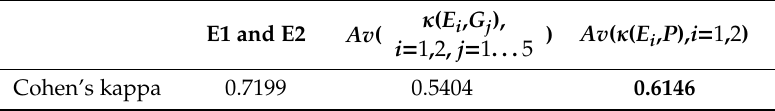
Figure 15. ( a ) good-quality images ( b ) inadequate quality due to blurriness, ( c ) inadequate quality due to low contrast and ( d ) inadequate quality due to inappropriate luminance. Table 9. Agreement grade indicated by Cohen’s kappa